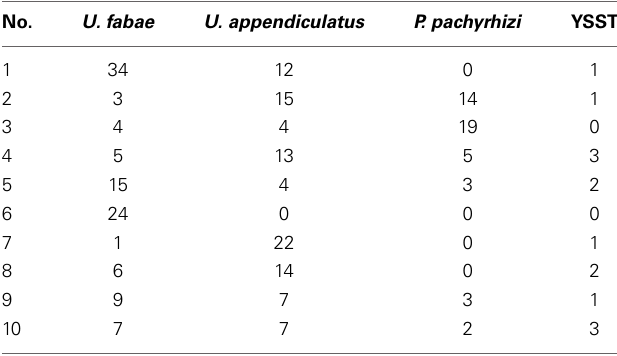
Table 1 | The 10 largest clusters of predicted secreted